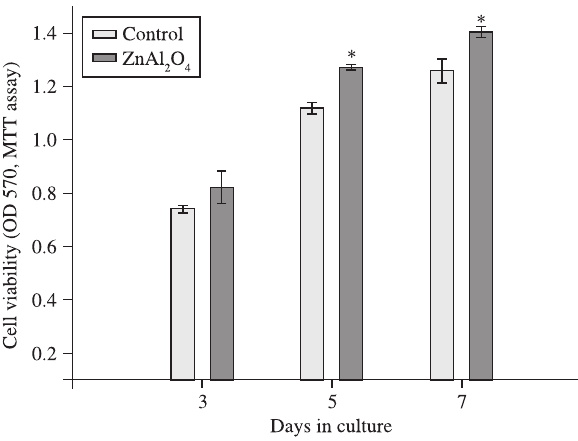
Figure 4. Cell viability of osteoblasts cells (MTT test) expressed as the absorb- ance at 570 nm for control corning glass (  ) and zinc aluminate ceramic film ( | | ) cultures. Asterisks indicate statistical significance ( p < 0.05).